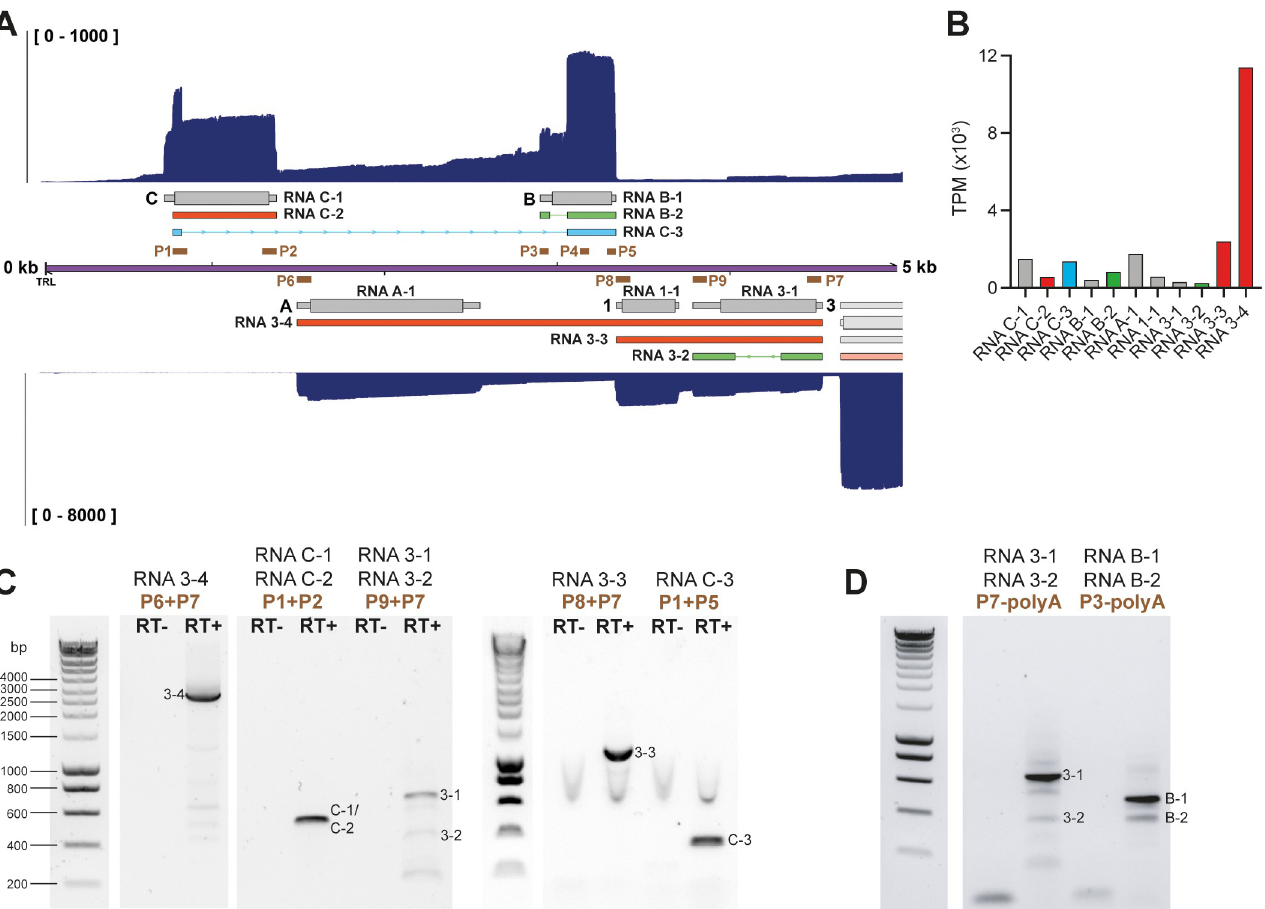
Fig 3. Structure of transcripts expressed from the unique left-end of the SVV genome. (A) Nanopore dRNA-seq coverage plots with annotated SVV transcripts of lytically SVV-infected BS-C-1 cells. Canonical with CDS (wide box) and UTR (thin box) in (grey), variant (orange), splice variant (green), fusion transcripts (blue) and non-coding (red) RNAs are indicated. Double black lines represent the SVV genome, with UL in purple fill, US in pink and IRS/TRS no fill and ticks indicate 1 kb intervals. Primers used for RT-PCR confirmation are indicated as brown boxes. (B) Bar graph indicating transcripts per million (TPM) counts for each transcript isoform. (C-D) RT-PCR on RNA extracted from lytically infected BS-C-1 cells at 96 hpi. When multiple bands are observed, sequence confirmed bands are indicated. RT+/RT-: reverse transcriptase added or omitted in cDNA synthesis. In (D) Strand-specific RT-PCR using a sequence specific forward primer and a poly-A reverse primer. Primer pairs are indicated and sequences are given in S5 Table.